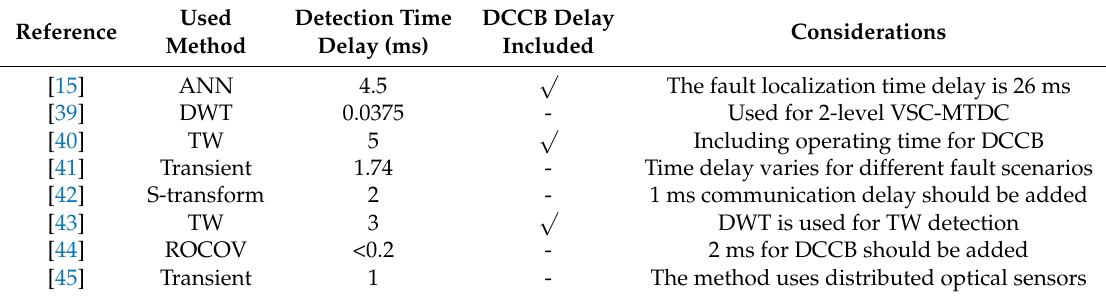
Table 7. Comparison of detection delay time with other literature